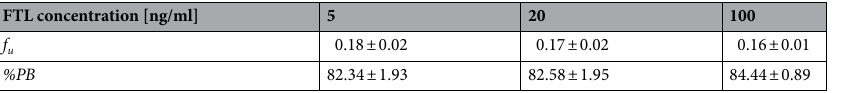
Table 5. The fraction unbound ( f u ) and protein binding ( %PB ) of fentanyl in rabbit plasma (n = 3). The results are presented as mean ± SD values.